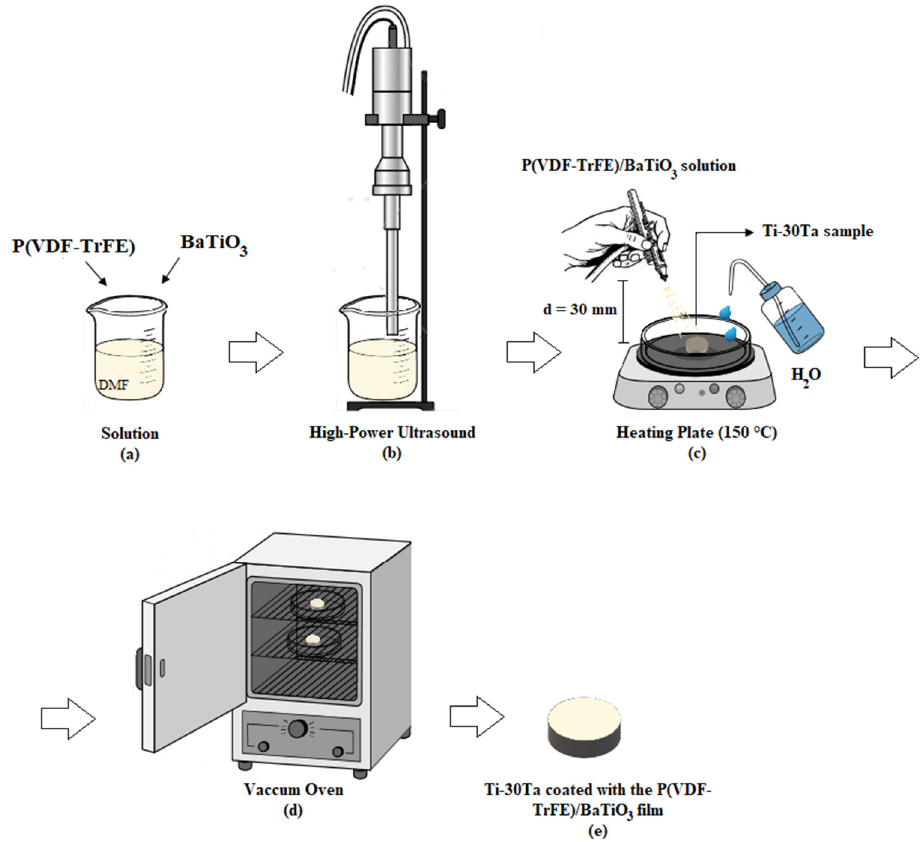
Figure 1. Illustrative coating process of cp-Ti and Ti-30Ta samples. ( a ) P(VDF-TrFE) and BaTiO 3 solubilization; ( b ) dispersion and disaggregation of BaTiO 3 particles in solution; ( c ) spray coating process; ( d ) samples dried in a vacuum oven; ( e ) final product obtained.